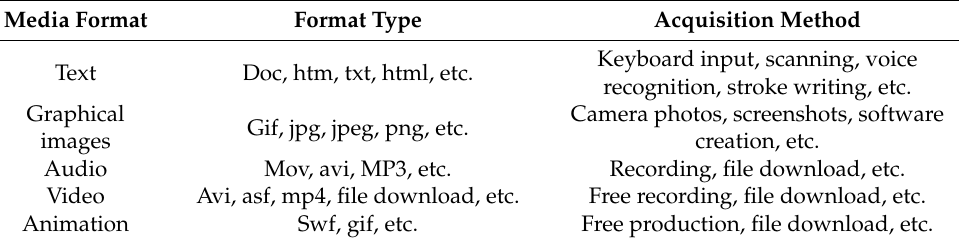
Table 3. Table of Interaction